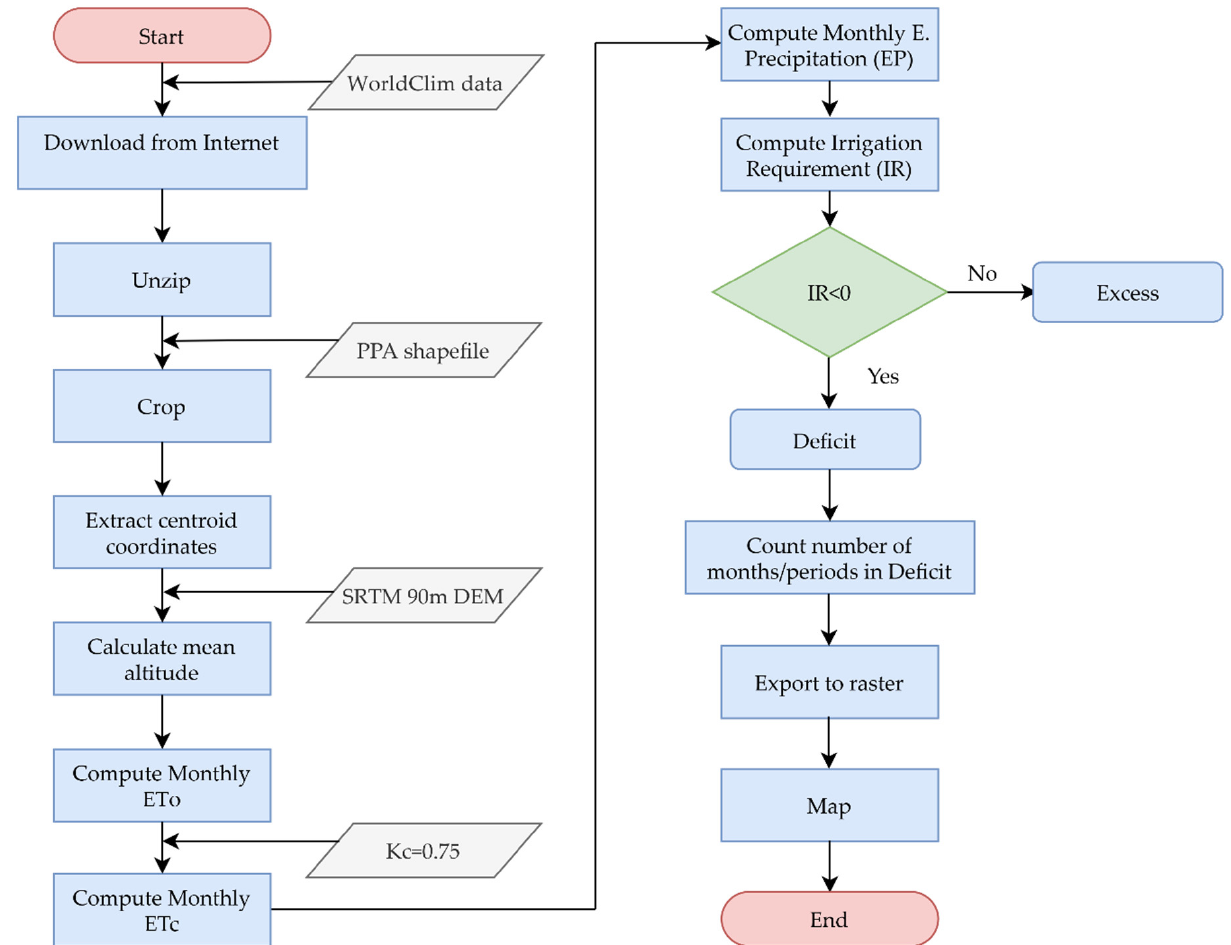
Figure 2. Flux diagram of IR computation.